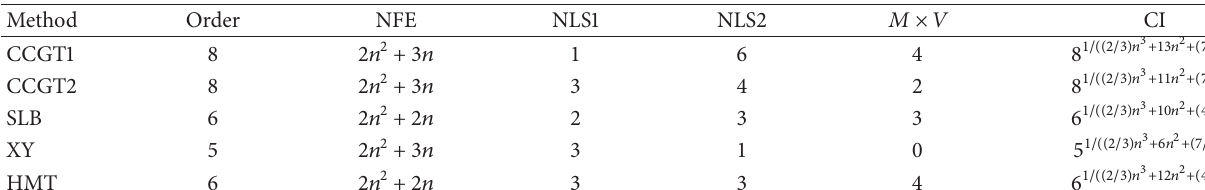
Table 2: Functional evaluations and products-quotients of the methods.